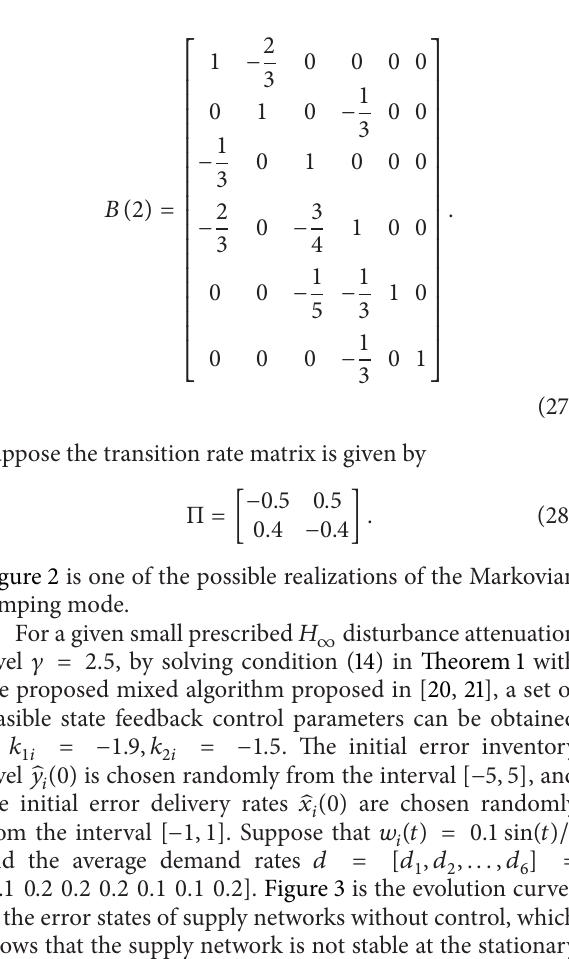
Figure 2: The numerical simulation of the Markovian jumping mode.